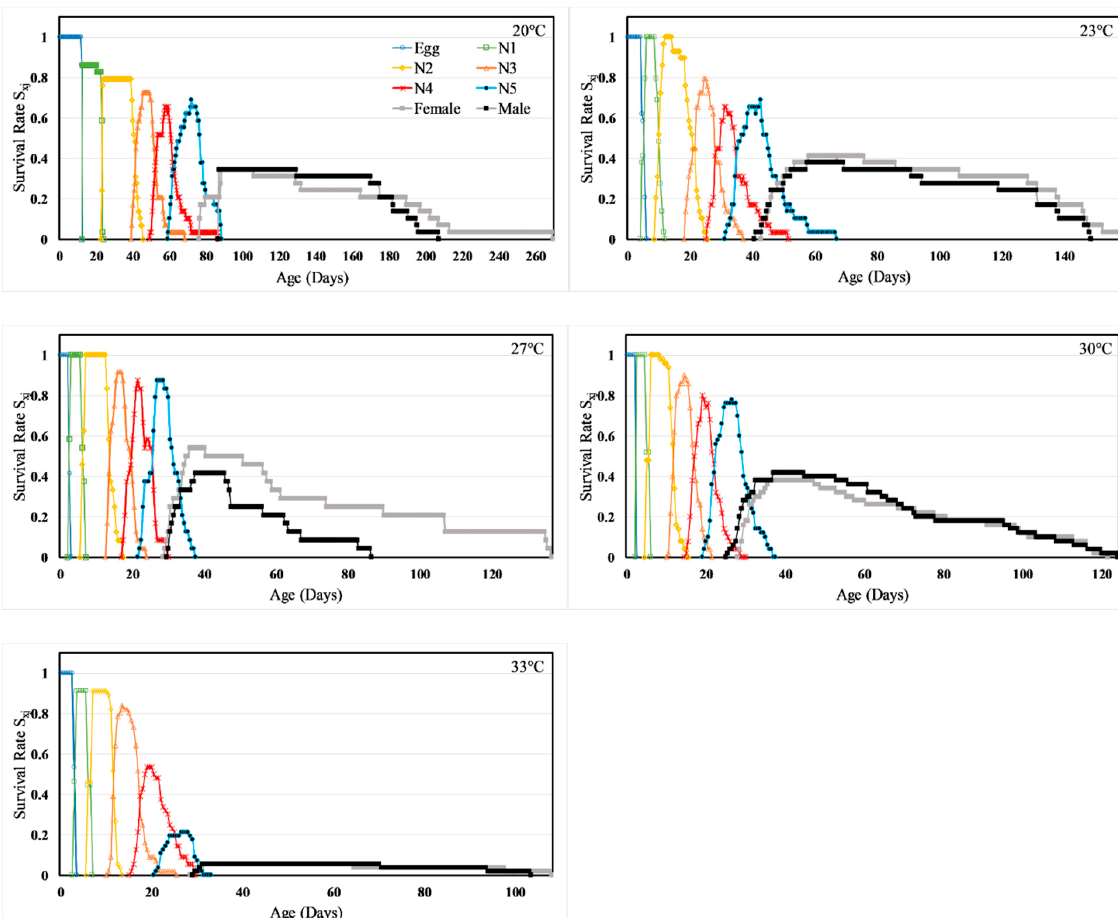
Figure 1. Temperature dependent age-stage-specific survival rate ( S xj ) of H. halys.